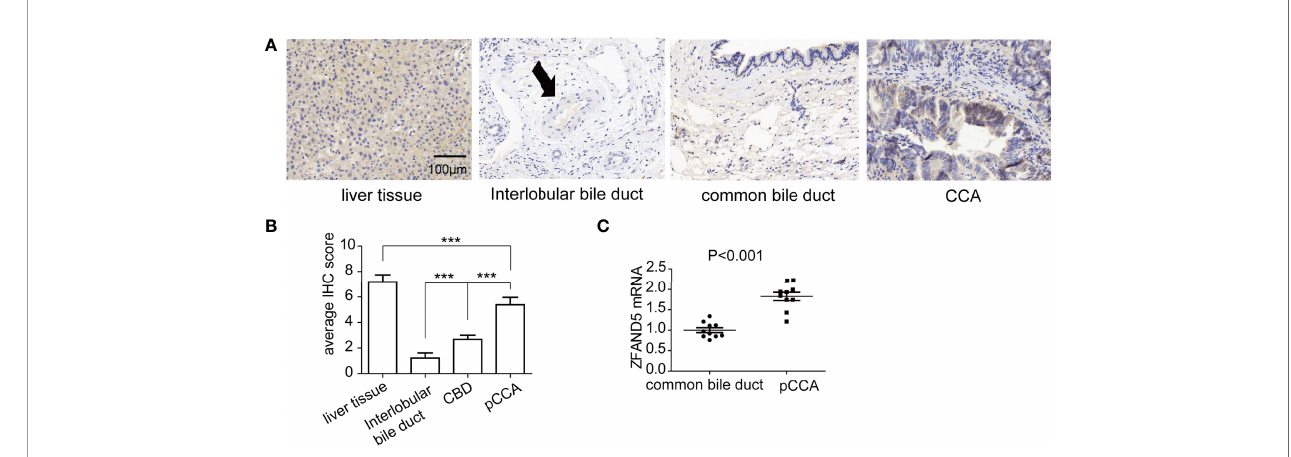
FIGURE 1 | The expressions of ZFAND5 in pCCAs, liver tissues, interlobar bile ducts tissues, and common bile ducts tissues. (A) The expressions of ZFAND5 in pCCAs, liver tissues, interlobar bile ducts tissues, common bile ducts tissues were detected by IHC. Scale bar: 100 m m. The arrow indicates the interlobar bile duct. (B) The expressions of ZFAND5 in pCCAs, liver tissues, interlobar bile ducts tissues, and common bile ducts tissues were estimated by the IHC scores. *** represents P < with one-way ANOVA test. (C) mRNAs of ZFAND5 in pCCAs and common bile ducts were detected with qRT-PCR. The statistical signi fi cance was analyzed by paired t